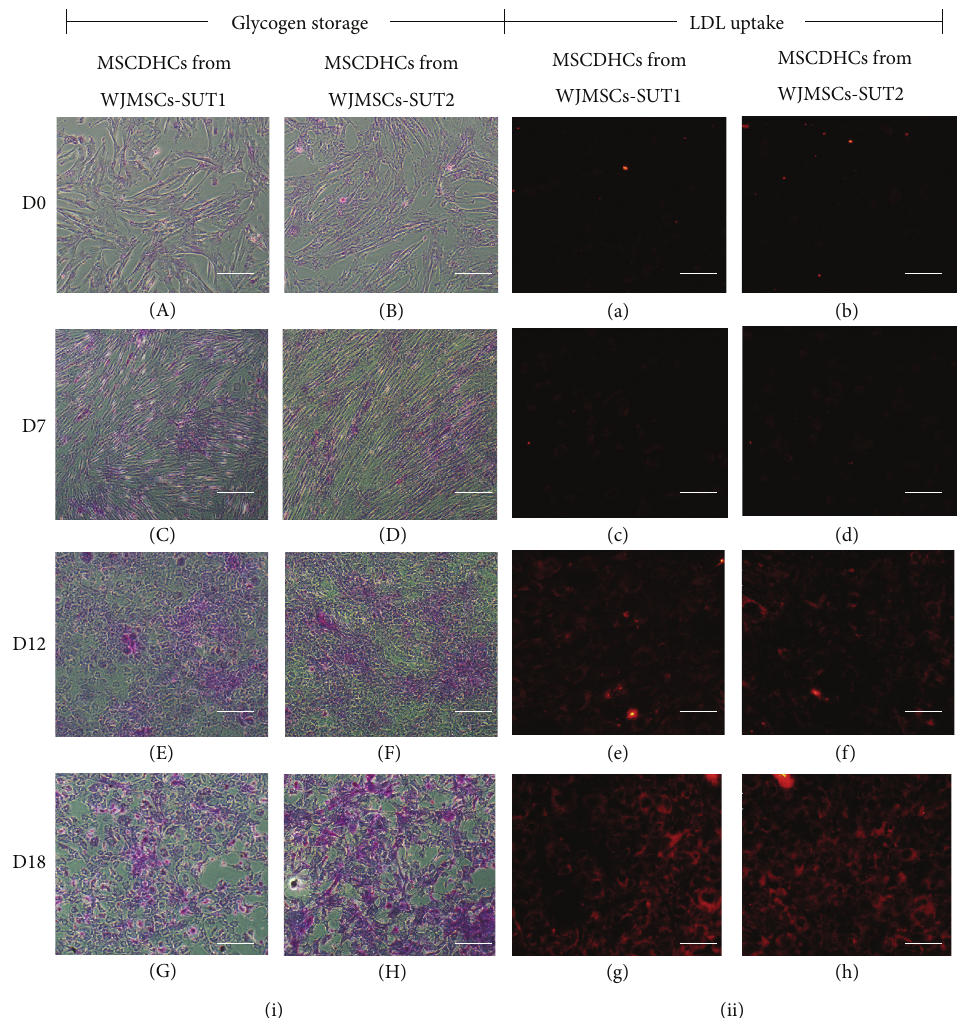
Figure 5: The capacities of the differentiated cells to store glycogen and accumulate LDL inside the cells after induction for 18 days. Glycogen storage of MSCDHCs generated from WJMSCs-SUT1 ((i): (A), (C), (E), and (G)) and WJMSCs-SUT2 ((i): (B), (D), (F), and (H)) were characterized by PAS staining following the differentiation period. LDL-uptake capacity of MSCDHCs generated from WJMSCs-SUT1 ((ii): (a), (c), (e), and (g)) and WJMSCs-SUT2 ((ii): (b), (d), (f), and (h)) were analyzed by LDL-uptake assay following the differentiation period. Original magnifications: ×100 for all pictures. Bars indicate 100 𝜇